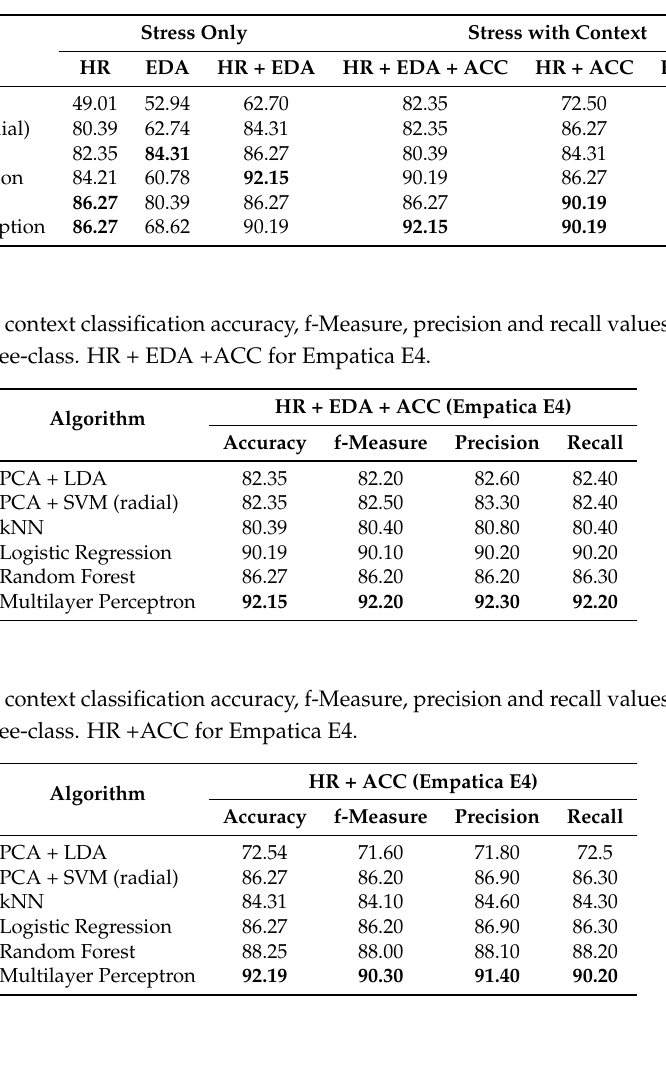
Table 3. Stress detection accuracies with different ML algorithms: three-class classification. On the left side, stress recognition results that only used HR and EDA signals are presented. On the right side, context information with accelerometer data is also added. The highest accuracy in every column is emphasized with bold.